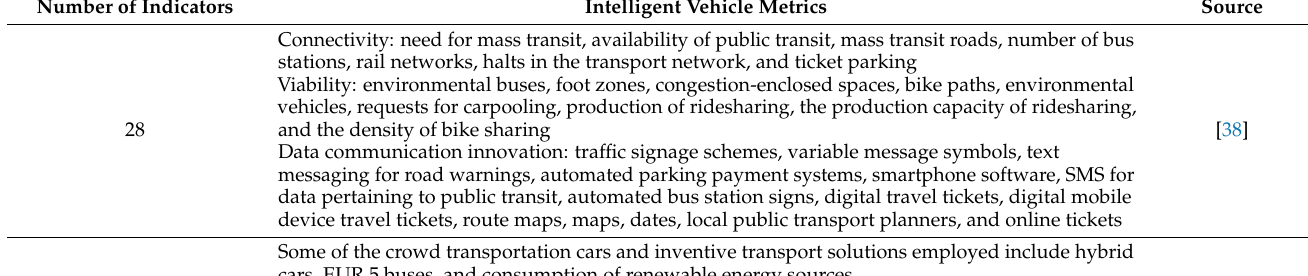
Table 6. List of metrics used in performance indicators for intelligent transport evaluation. Number of Indicators Intelligent Vehicle Metrics Source